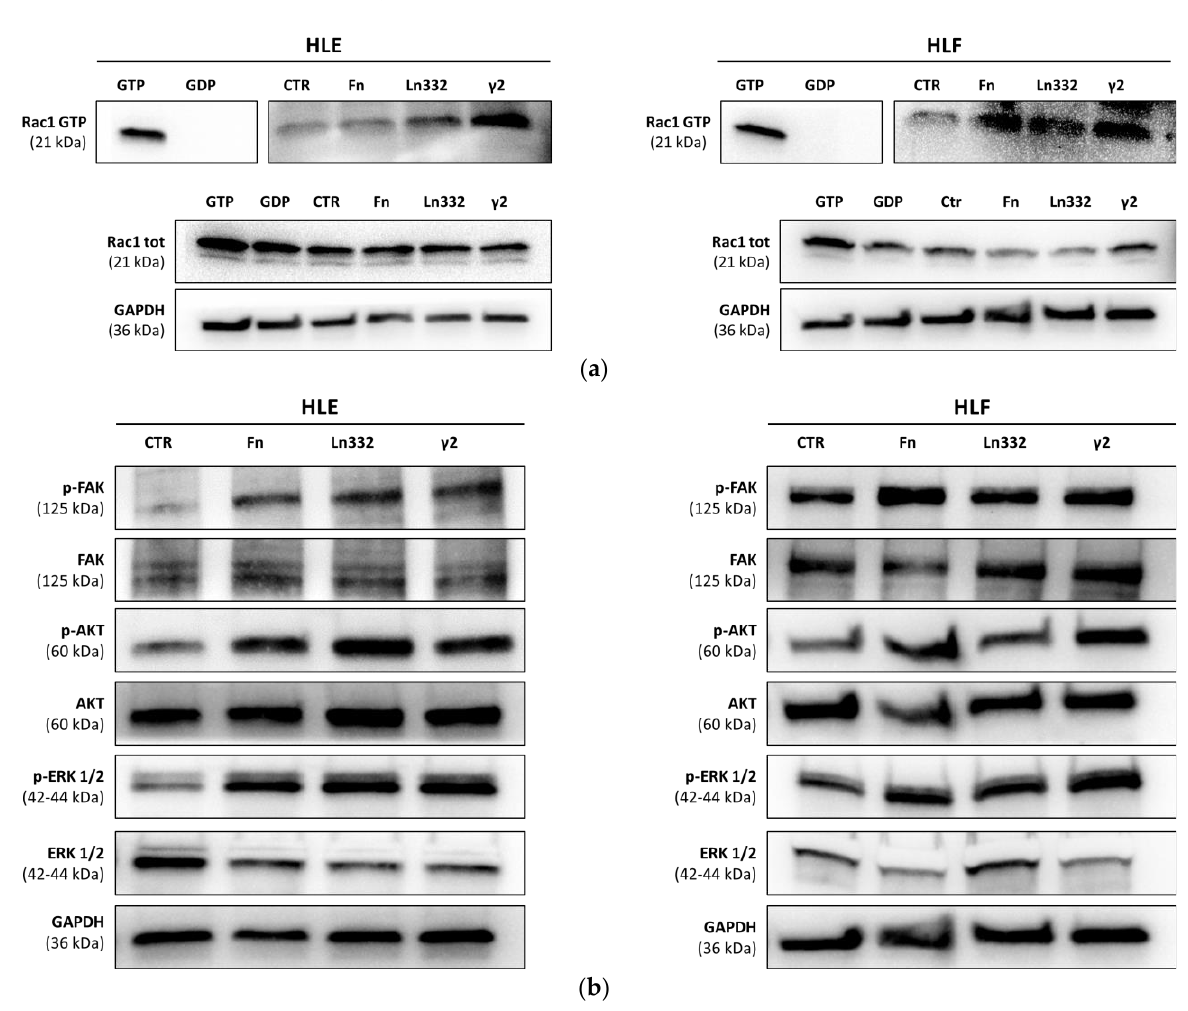
Figure 2. Adhesion of HCC cells onto γ 2 chain of Ln332 promotes activation of pro-migratory signaling mediators. ( a ) Western blot analysis for active Rac1 (Rac1-GTP) protein levels in HLE and HLF upon seeding and 30 min spreading on uncoated, fibronectin (Fn), Ln332, or γ 2-coated surfaces. ( b ) Western blot analysis for phospho-FAK, phospho-Akt, and phospho-ERKs in HLE and HLF cells upon seeding and 30 min spreading on uncoated, Fn, Ln332, or γ 2-coated surfaces. These experiments were performed in replicate (see Figure S2 for row blots).